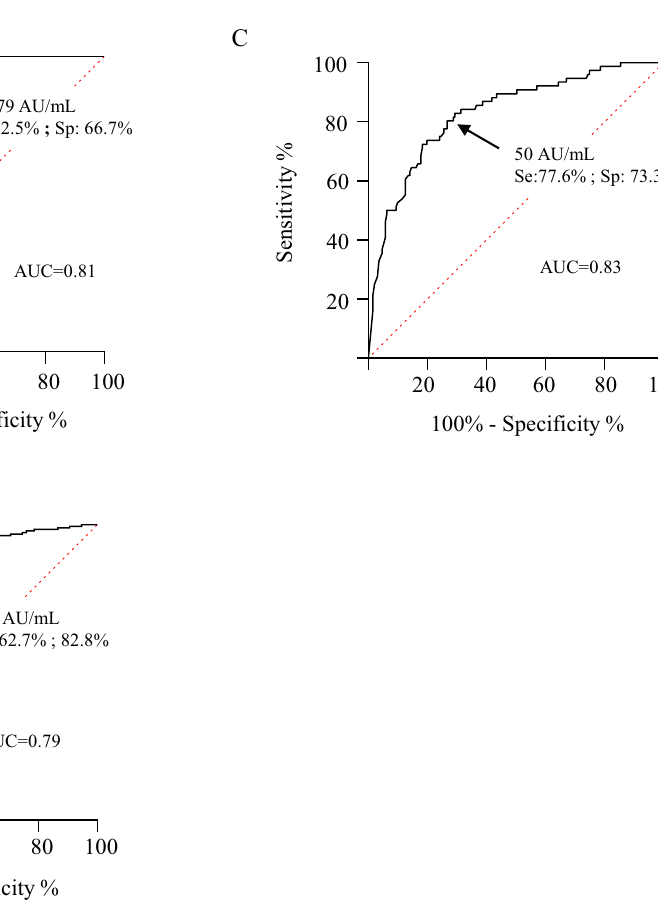
Figure 1. RBD-IgG vaccine response after first and second doses. ( A ) Individual changes in RBD-IgG levels after first and second doses in NH residents with and without prior SARS-CoV-2 infection. RBD-IgG between first and second doses in NH residents with (red) and without (green) prior SARS-CoV-2 infection. ( B ) ROCs to evaluate RBD-IgG levels after the first dose, predictive of the lack of additional gain in RBD-IgG following the second dose in NH residents with prior SARS-CoV-2 infection; for a RBD-IgG level > 12,079 AU/mL: positive predictive value (PPV): 76.7%, negative predictive value (NPV): 54.5%, sensitivity: 92.5%; specificity: 66.7%. ( C ) ROC evaluating RBD-IgG levels after the first dose, predictive of the failure to reach a significant RBD-IgG level after the second dose (< 1050 AU/mL) in NH residents without prior SARS-CoV-2 infection; RBD-IgG < 50 AU/ mL: PPV: 53.5%; NPV: 89.2%; sensitivity: 77.6%; specificity: 73.3%. ( D ) ROC to evaluate the RBD-IgG level after the first dose, predictive of a high RBD-IgG level following the second dose (≥ 4160 AU/mL) in NH residents without prior SARS-CoV-2 infection; RBD-IgG > 228 AU/mL: PPV: 58.8%; NPV: 85.0%; sensitivity: 82.8%; specificity: